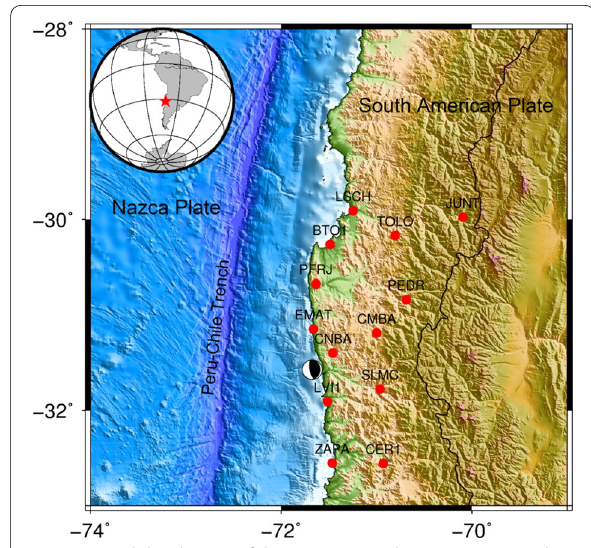
Fig. 1 Spatial distribution of the epicenter and 13 GNSS sites. Red circles represent GNSS sites, and the beach ball indicates the focal mechanism of this